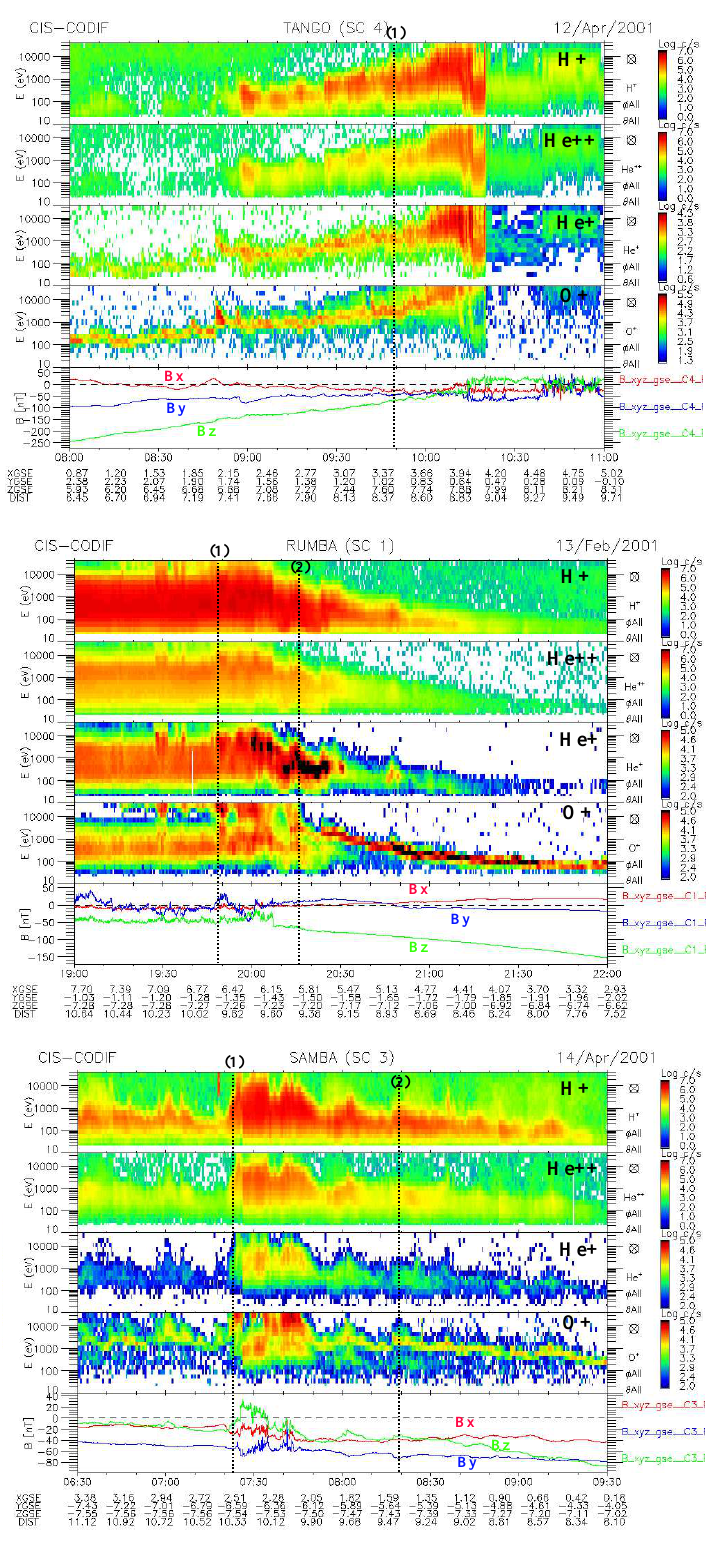
Fig. 1. Time-energy spectrograms of four ion species (H + , He ++ , He + and O + ) and geomagnetic field components. From the top panel 12 April 2001, 13 February 2001, and 14 April 2001,